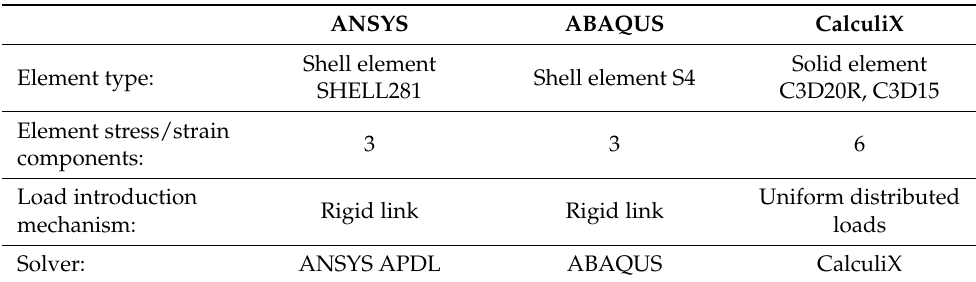
Table 4. Comparison of the modelling